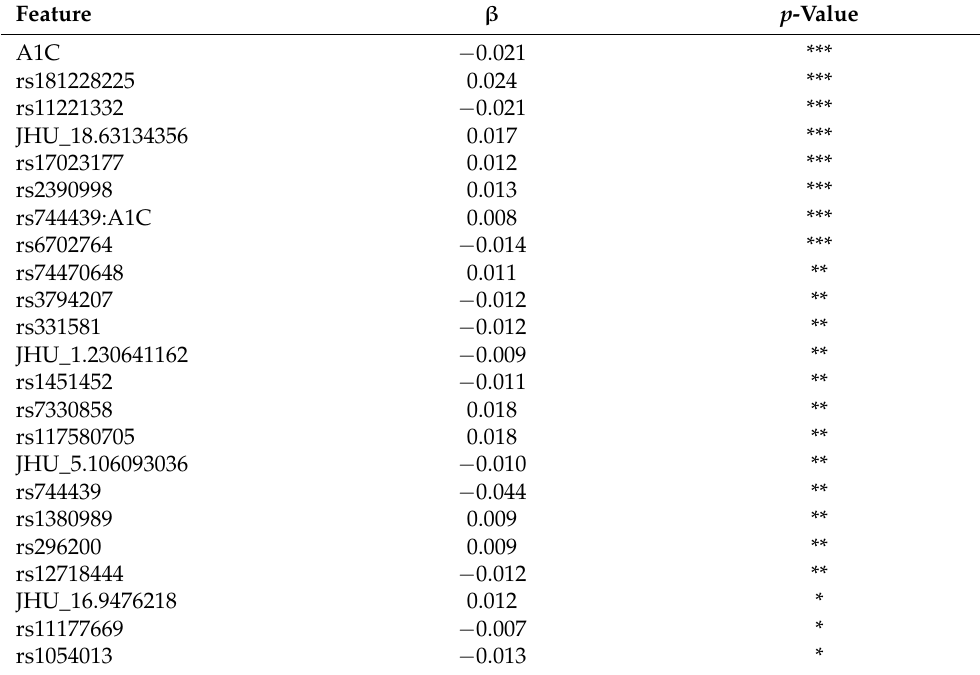
Table 7. Association estimates for features in final multivariate G + E meQTL regression model with one GxE term for